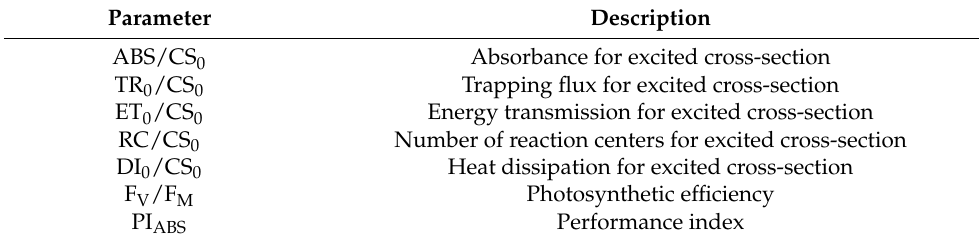
Table 1. Description of the measured photosynthetic parameters. Parameter Description ABS/CS 0 Absorbance for excited cross-section TR 0 /CS 0 Trapping flux for excited cross-section ET 0 /CS 0 Energy transmission for excited cross-section Number of reaction centers for excited cross-section Photosynthetic efficiency PI ABS Performance